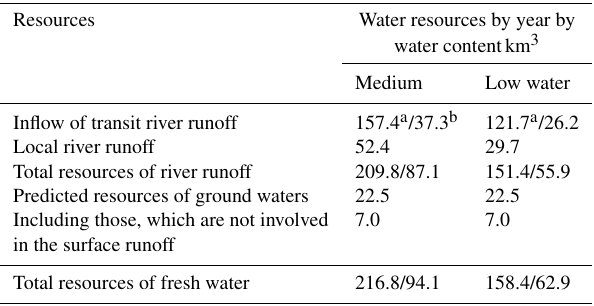
Figure 1. Distribution of the average rate of runoff over the territory of Ukraine. Table 1. Water resources of Ukraine.